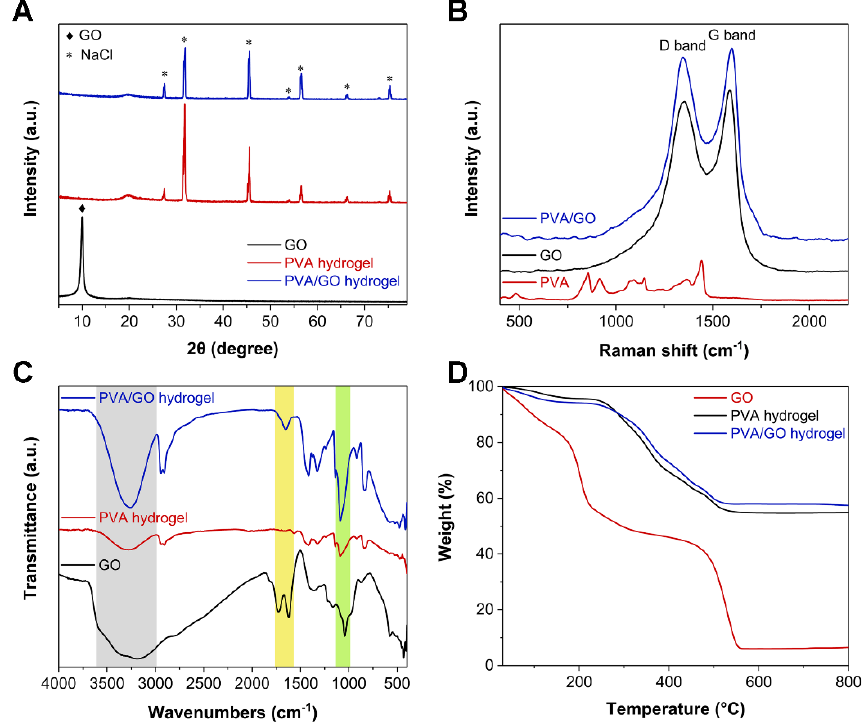
Figure 4. Chemical composition analysis of GO, PVA hydrogel, and PVA/GO hydrogel. ( A ) XRD patterns. ( B ) Raman spectra. ( C ) FTIR spectra. ( D ) TGA